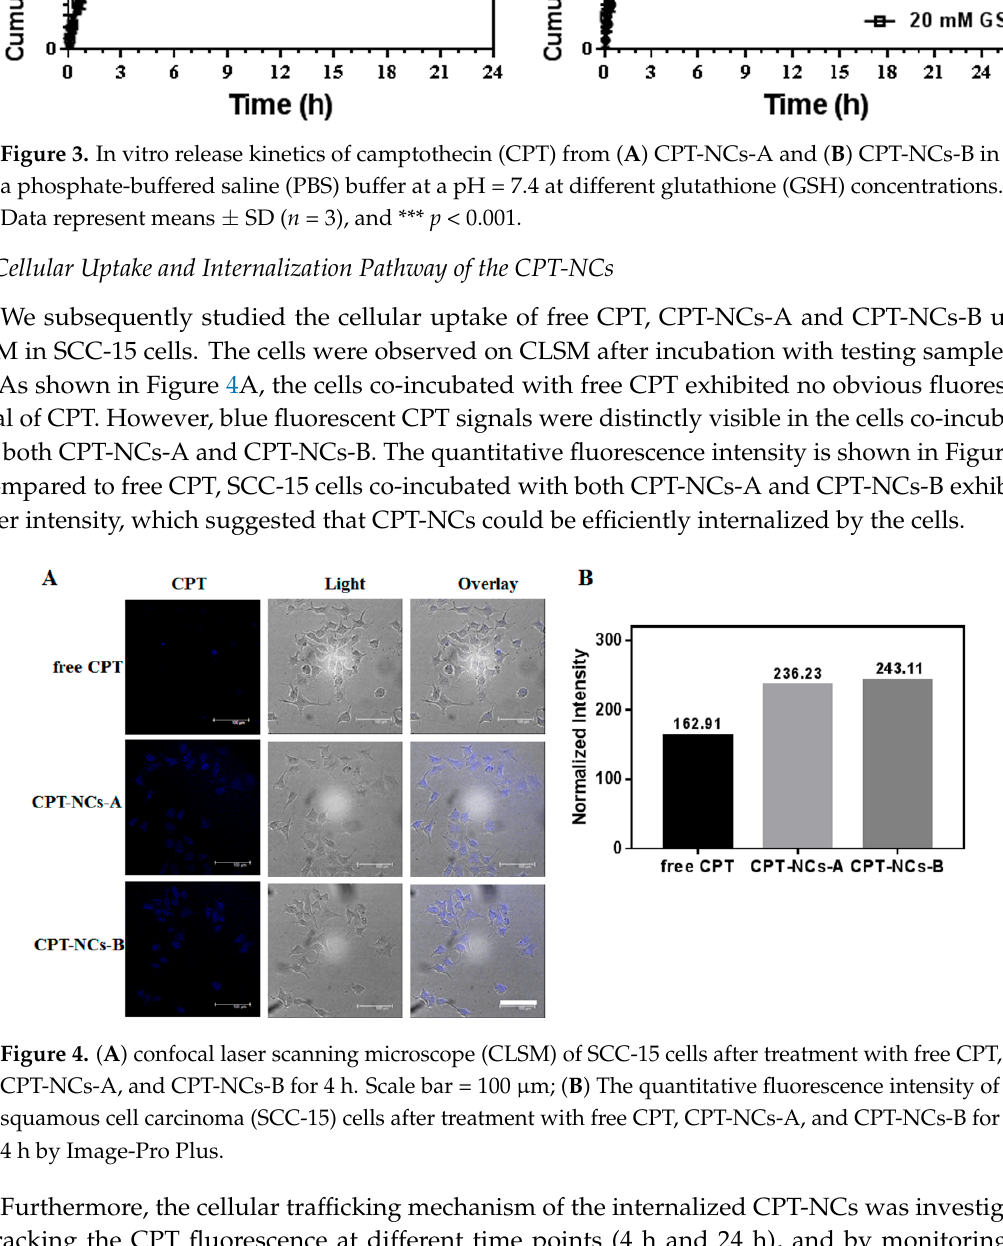
Figure 5. ( A ) CLSM of LysoTracker Green staining (green = endosomes or lysosomes, red = CPT) of SCC-15 cells after treatment with free CPT, CPT-NCs-A, and CPT-NCs-B for 4 h and 24 h. Scale bar = 20 μ m; ( B ) Co-localization analysis of SCC-15 cells after treatment with free CPT, CPT-NCs-A, and CPT-NCs-B for 4 h and 24 h by Image-Pro Plus; ( C ) Pearson’s correlation coefficient of the red/green fluorescence in SCC-15 cells after treatment with free CPT, CPT-NCs-A, and CPT-NCs-B for 4 h and 24 h ( n = 3).